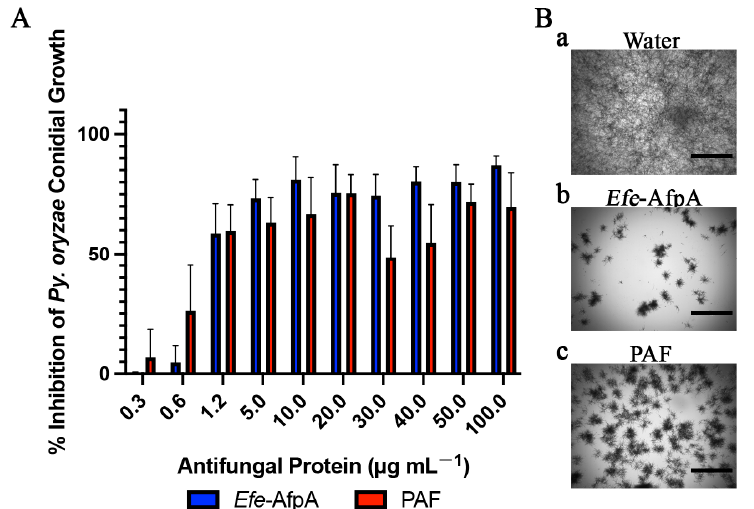
Figure 5. Activity of Efe -AfpA and PAF against Py. oryzae conidial growth. ( A ) Growth inhibition of Py. oryzae conidia treated with increasing concentrations of either Efe -AfpA or PAF incubated at room temperature for 48 h. The data presented are the means and standard deviations of three replicates. ( B ) Microscopy of Py. oryzae conidia treated with water or 100 μ g mL − 1 of either Efe -AfpA or PAF. Bars are 750 μ m.